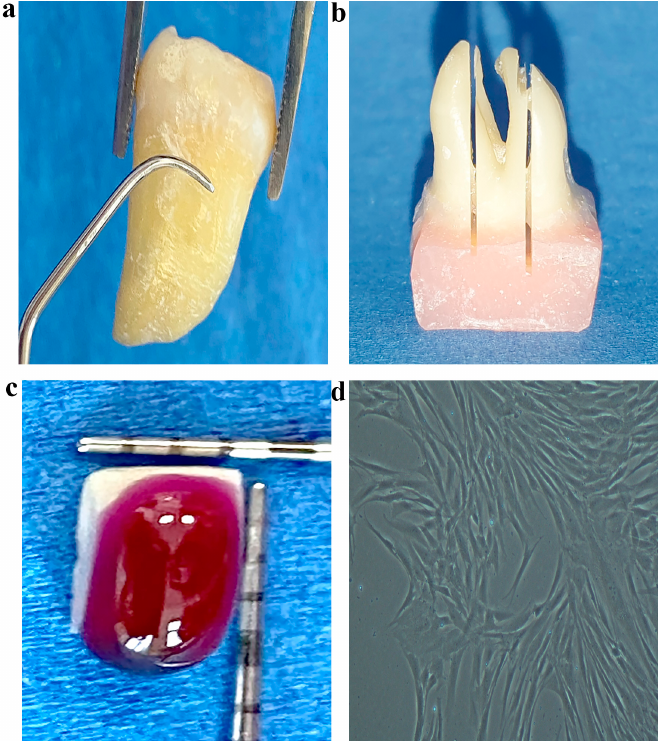
Figure 1. Sample preparation for SEM analysis. ( a ) Root scaling; ( b ) longitudinally sectioned roots; ( c ) HI on a standard root sample; ( d ) MSCs prepared to be harvested at 80% confluence.